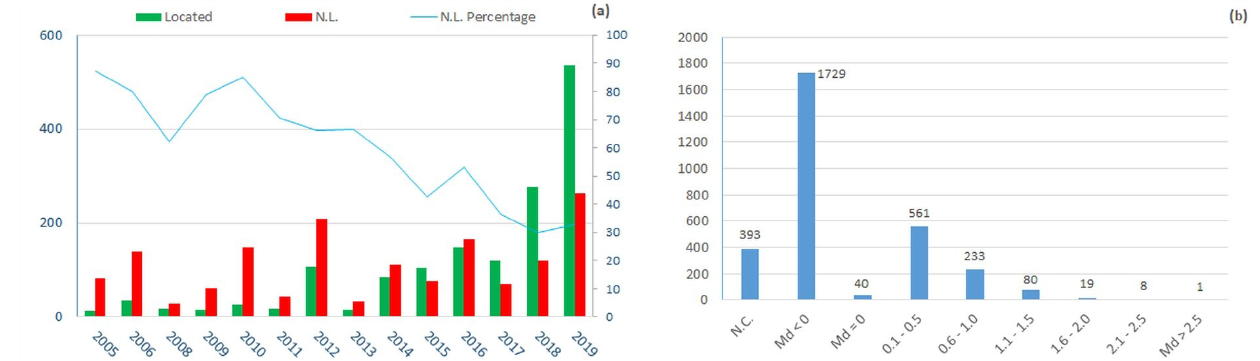
Figure 3. VT earthquake distributions: (a) Temporal distribution of located VT earthquakes and N.L. (left axis) and percentage of N.L. respect to all the VT earthquakes (right axis); (b) VT earthquakes distribution over M d